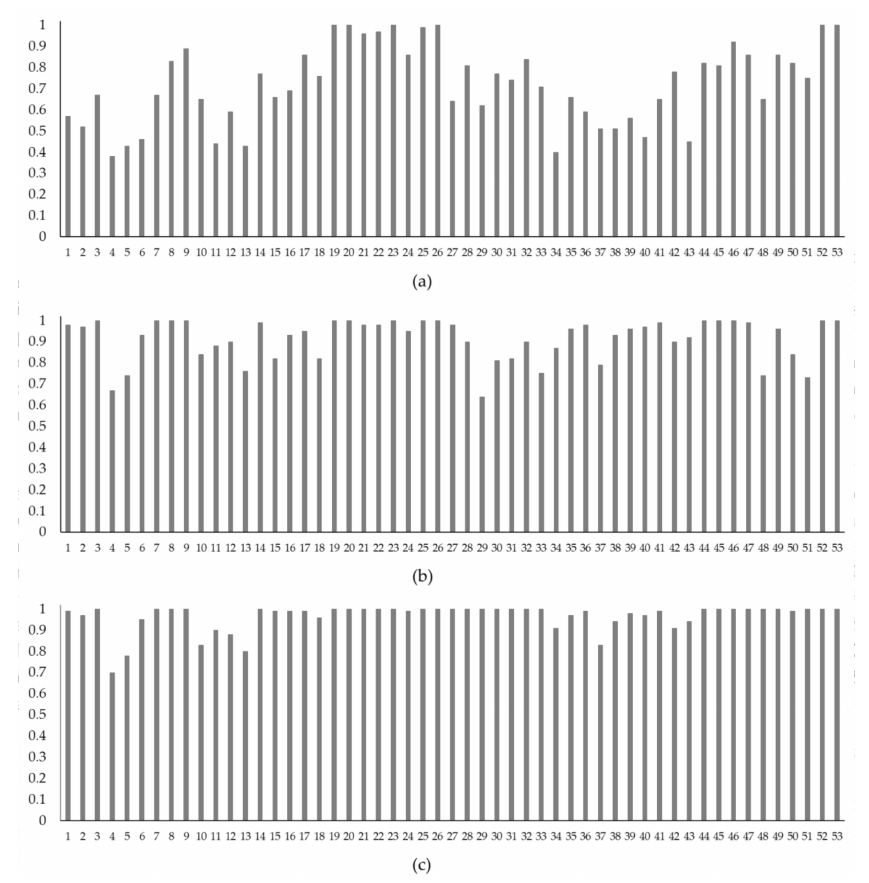
Figure 10. Percentage that the location with the maximum P i ( d ) is identical to the correct spill location: ( a ) unified model 1 with 2 sensors at (26, 53); ( b ) unified model 2 with 4 sensors at (9, 26, 46, 53); and ( c ) unified model 3 with 6 sensors (9, 19, 26, 33, 46, 53).